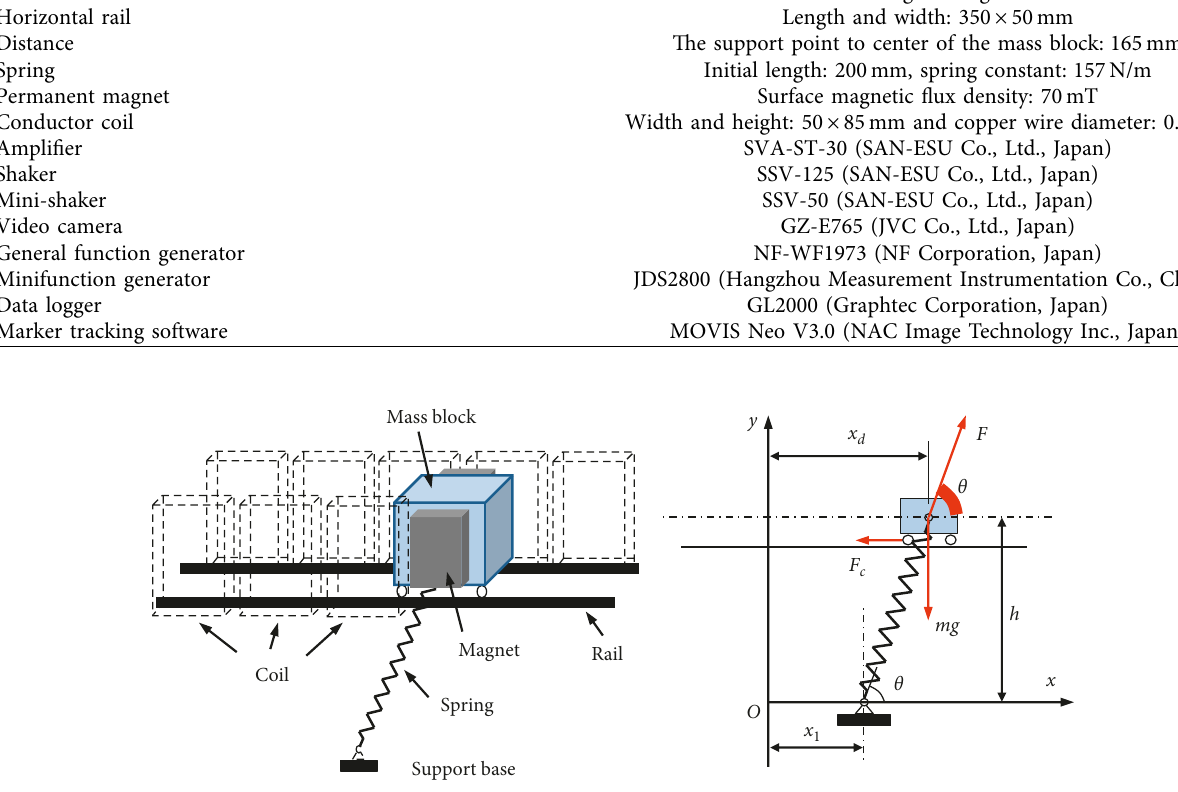
Figure 3: Bistable motion energy harvesting analysis model using a magnet and coil.